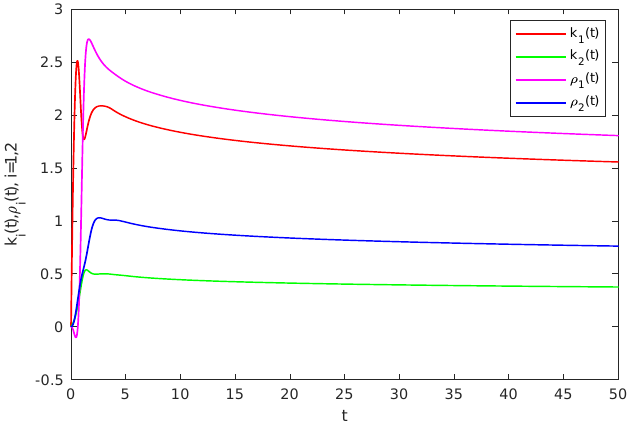
Figure 15. The evolution of control gains k p ( t ) and ρ p ( t )